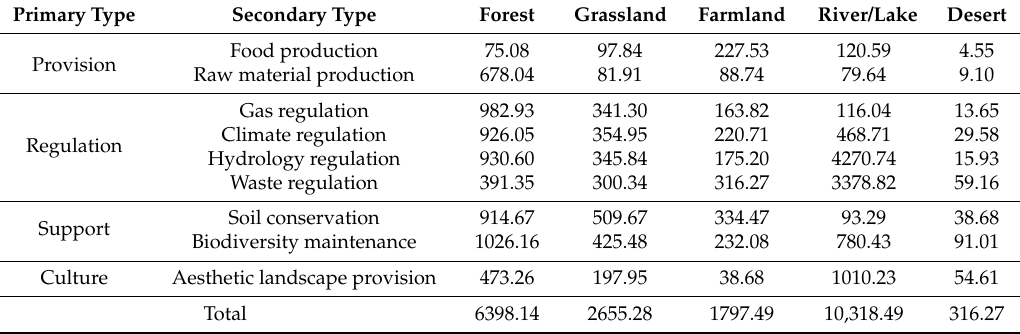
Table 2. Values of each ecological service per unit area of ecosystem in Qinghai Province (unit: yuan/hm 2